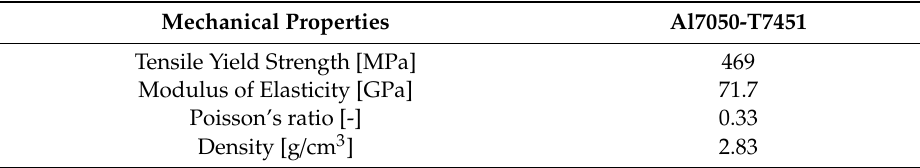
Table 1. Mechanical properties of aluminium alloy Al7050-T7451 [23,26]. Mechanical